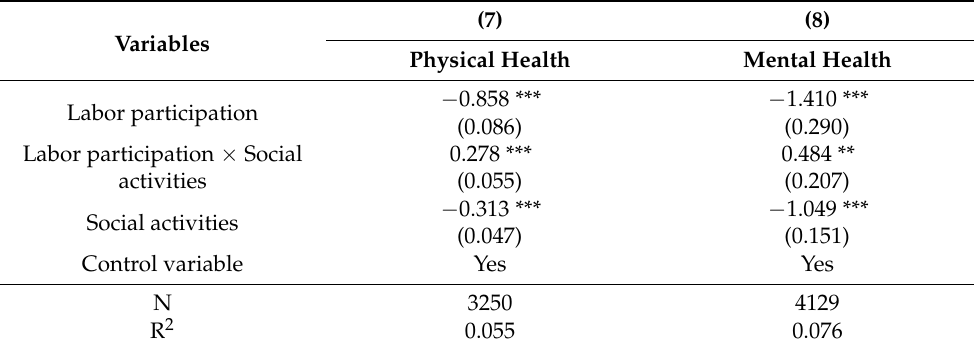
Table 6. Regression results of moderating effects (the moderating variable was social